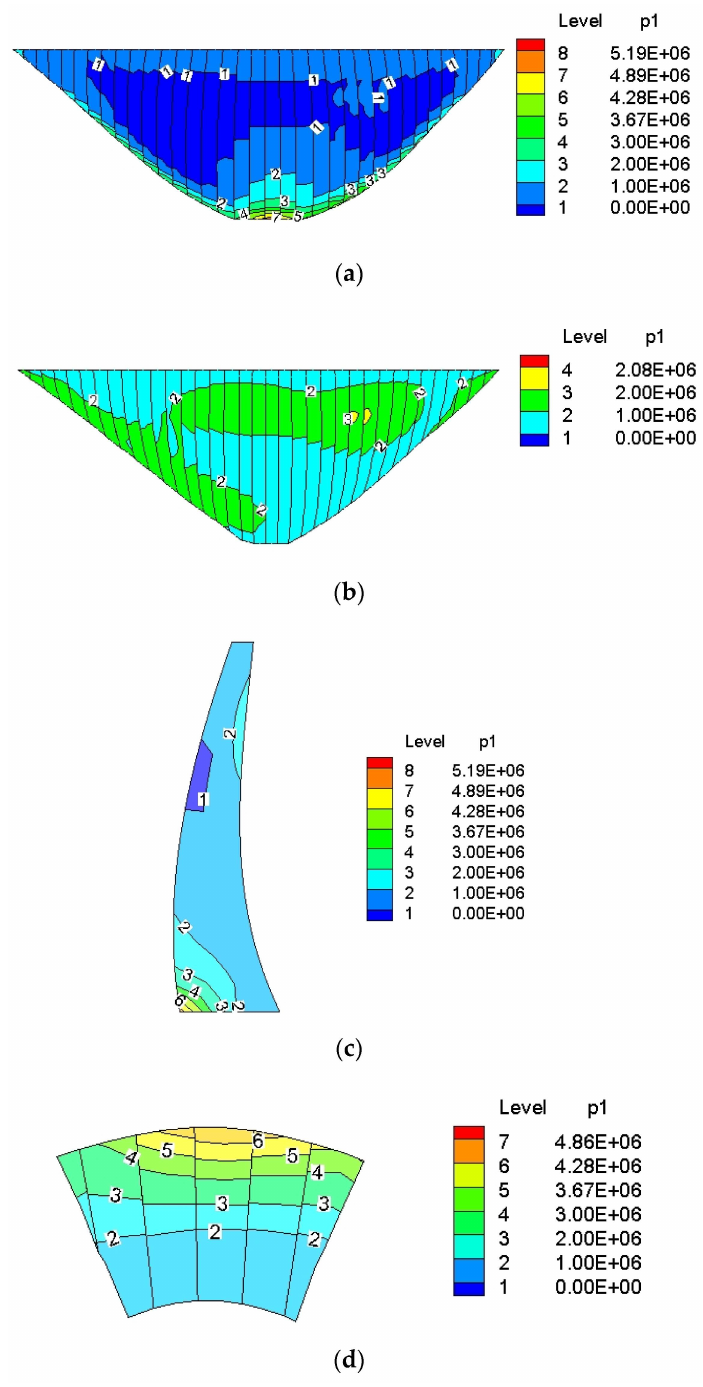
Figure 6. Envelopes of maximum tensile principal stresses using the old standard (Pa). ( a ) Up- stream surface, ( b ) downstream surface, ( c ) section of arch crown beam, and ( d ) arch section at dam bottom